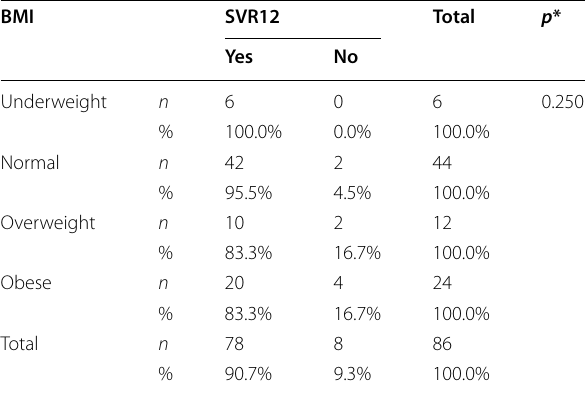
Table 5 Analysis of the correlation of BMI with virological